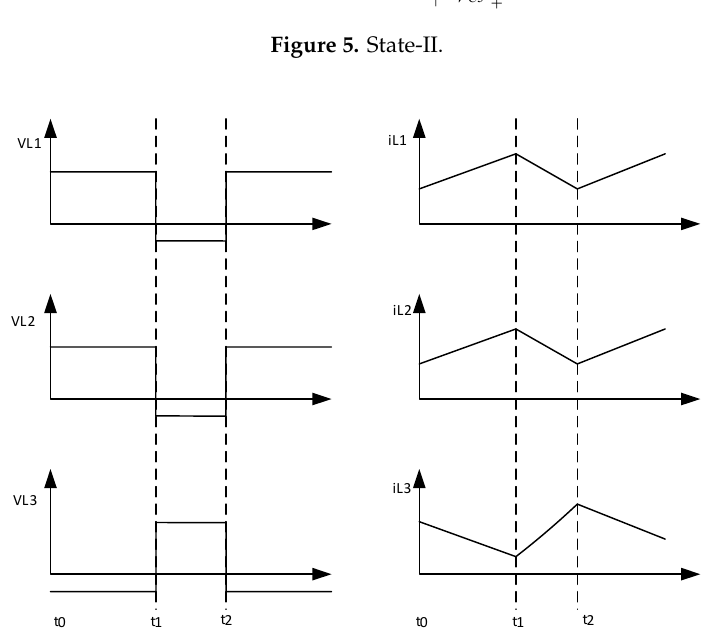
Figure 5. State-II.